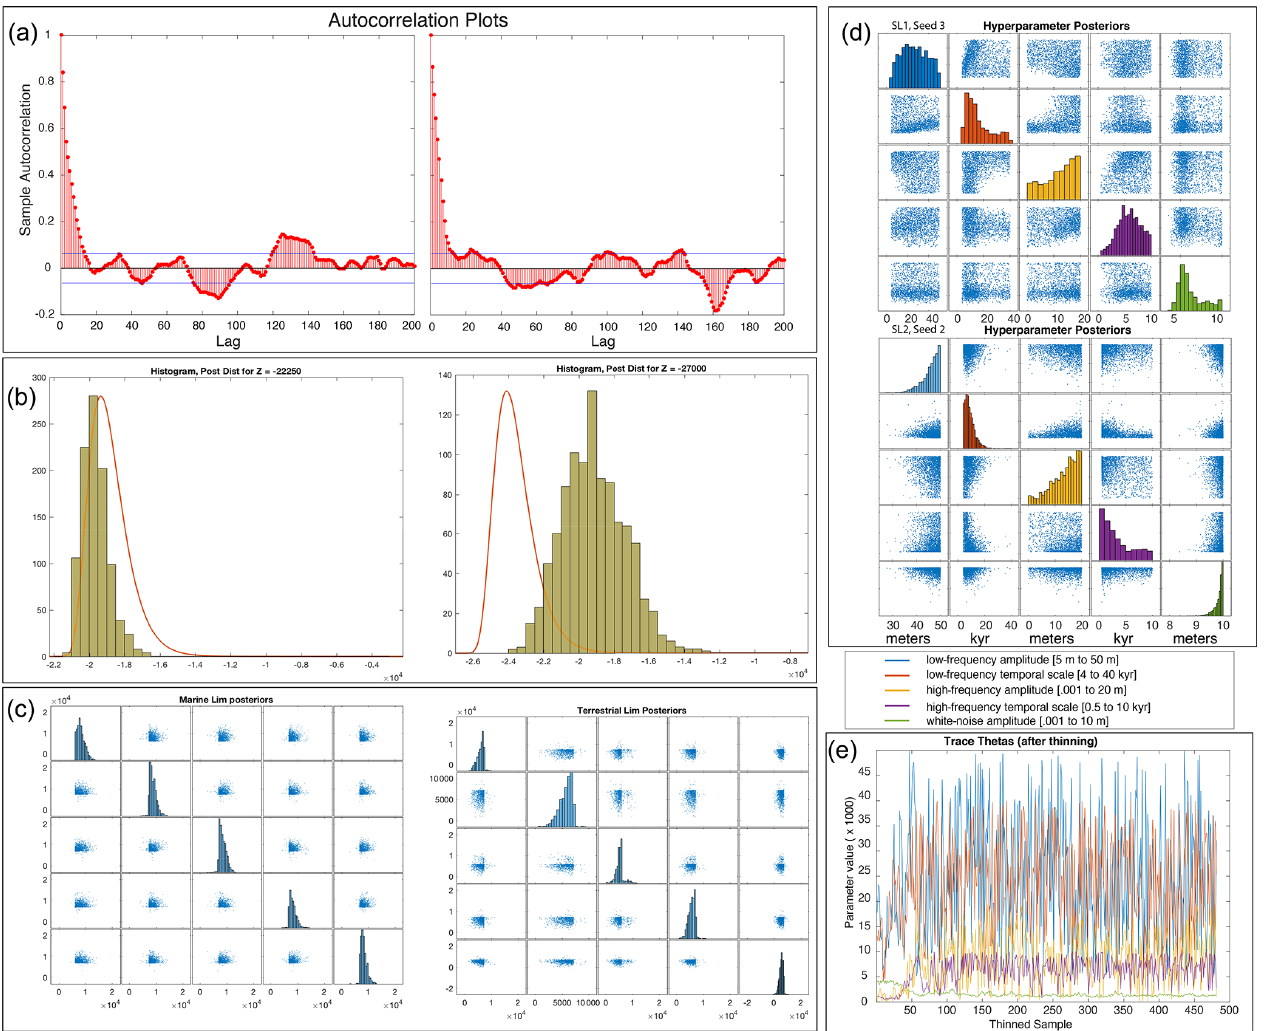
Figure D1. Model diagnostics. (a) Autocorrelation plots show the autocorrelation between one sample and the following sample in order to determine the number of samples to discard to result in independent samples of the posterior distribution. (b) Two examples of prior likelihoods of proxy data (red line) and a tan histogram representing the (thinned) posterior sample distribution after going through the sam- pling module. This posterior distribution of samples (similar to the samples in Fig. 1d and e) may be significantly different from the prior likelihood because of the correlation with other data points that are close in age, such that other data may have influenced the posterior like- lihoods. (c) Plots of posterior distributions (diagonal plots) of marine- and terrestrial-limiting data show that the data samples are correlated (off-diagonal plots). (d) Examples of posterior distributions of the hyperparameters of the model for sea-level curve 1 (SL1) and sea-level curve 2 (SL2), where the distributions are colored to match the hyperparameter that they represent, shown in the legend. The bounds on each parameter’s uniform prior are also shown in the legend. (e) The trace plot shows the progression of values to check for convergence.